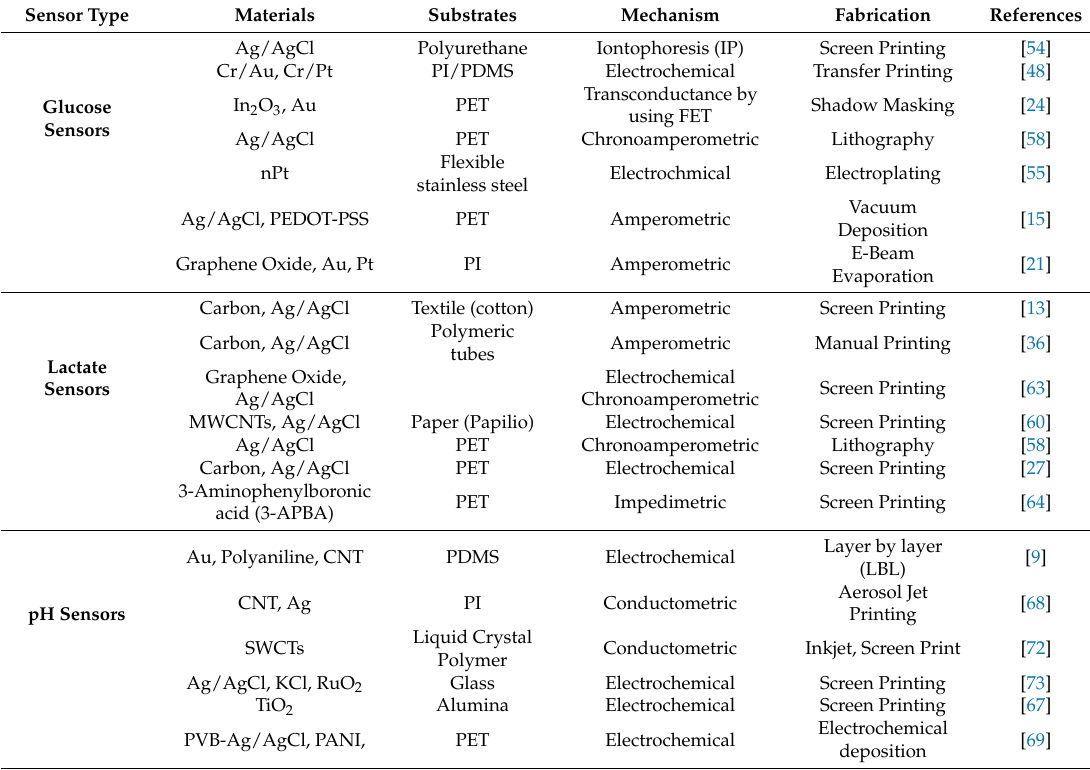
Figure 8. ( a ) Optical image of electrochemical sensor attached to the skin wet with sweat; ( b ) correlation of glucose concentration (left) and pH (right) measured by sensors ( x -axis) with those measured by a commercial glucose assay kit and commercial pH meter ( y -axis) in human sweat [9] (reproduced with permission). Table 1. Summary of representative materials, substrates, mechanisms, and fabrication procedures for fluidic-based